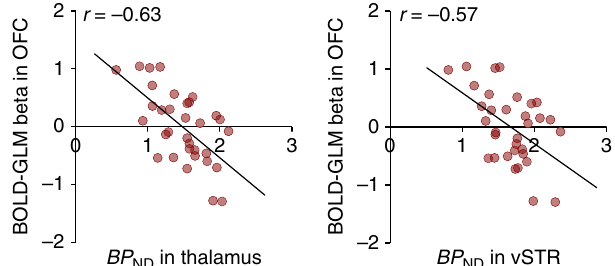
Fig. 5 Regional association and least-squares regression lines between BOLD-fMRI contrast to palatable minus non-palatable foods in the orbitofrontal cortex (OFC) and [ 11 C]carfentanil BP ND in the thalamus and ventral striatum ( n = 33). The data are plotted for visualization purposes only, and statistical inference is based on the full-volume